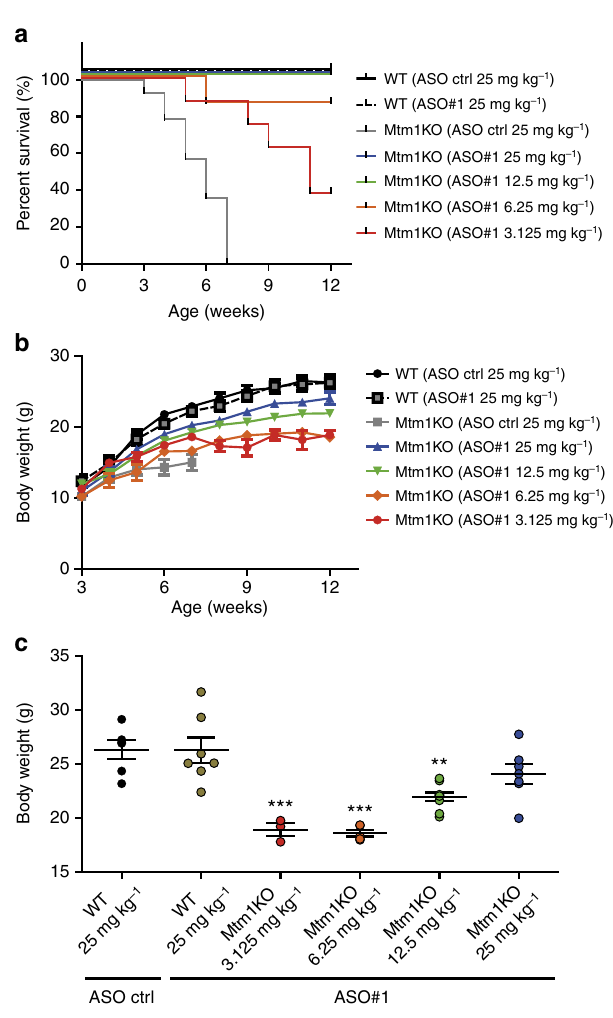
Figure 3 | Dose–response effect of ASO- Dnm2 systemic injections. Representation of survival percentage ( a ) and whole-body weight evolution ( b ) of WT injected with 25mgkg (cid:2) 1 ASO control (ctrl) or ASO#1, or Mtm1KO injected with 25mgkg (cid:2) 1 ASO ctrl or different doses of ASO#1. ( n ¼ 7 mice per group at week 3). ( c ) Dots represent individual body weight of ASO-treated WT or Mtm1KO mice at week 12 (sacrifice day). n ¼ 5–7 mice per group except for Mtm1KO treated with 3.125mgkg (cid:2) 1 where n ¼ 3. ** P o 0.01, *** P o 0.001 for mice treated with ASO#1 versus WT treated with ASO control (ANOVA test followed by post hoc